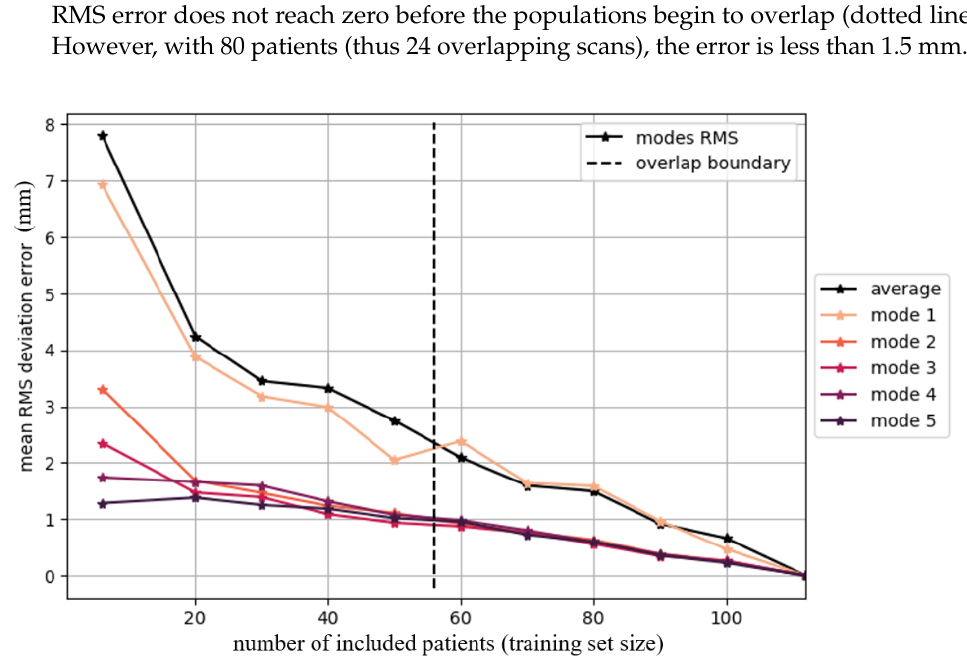
Figure 4. Average RMS deviation between the 112 Asian Femur SSMs computed by leaving each patient out once, with an increasing number of modes. The error bars indicate the standard devia- tions. 3.3. Use of the SSM 3.3.1. Definition of a Representative Database of 3D Bone Models The AP/ML dimensions of the seven Caucasian bone models and the five Asian bone models lie in the middle of the cloud representing the AP/ML dimensions of the individ- ual patients (Figure 5). The AP/ML dimensions of the seven Caucasian bone models ranged from (53.6/64.9 mm) for size 1 to (67.7/80.7 mm) for size 7. The AP/ML dimension of the five Asian bone models ranged from (53.0/62.4 mm) for size 1 to (60.5/72.4 mm) for size 5. The dimensions of the 10 additionally generated bones deviated from the target dimension on average (±1 standard deviation) by 0.2 ± 0.4 mm in AP and 0.5 ± 0.5 mm in